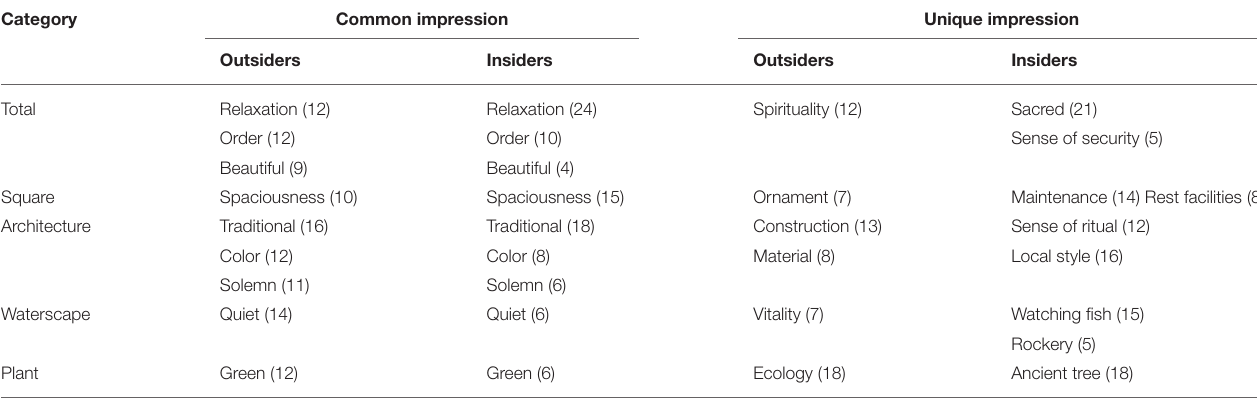
TABLE 3 | Participants’ reactions to the sacred